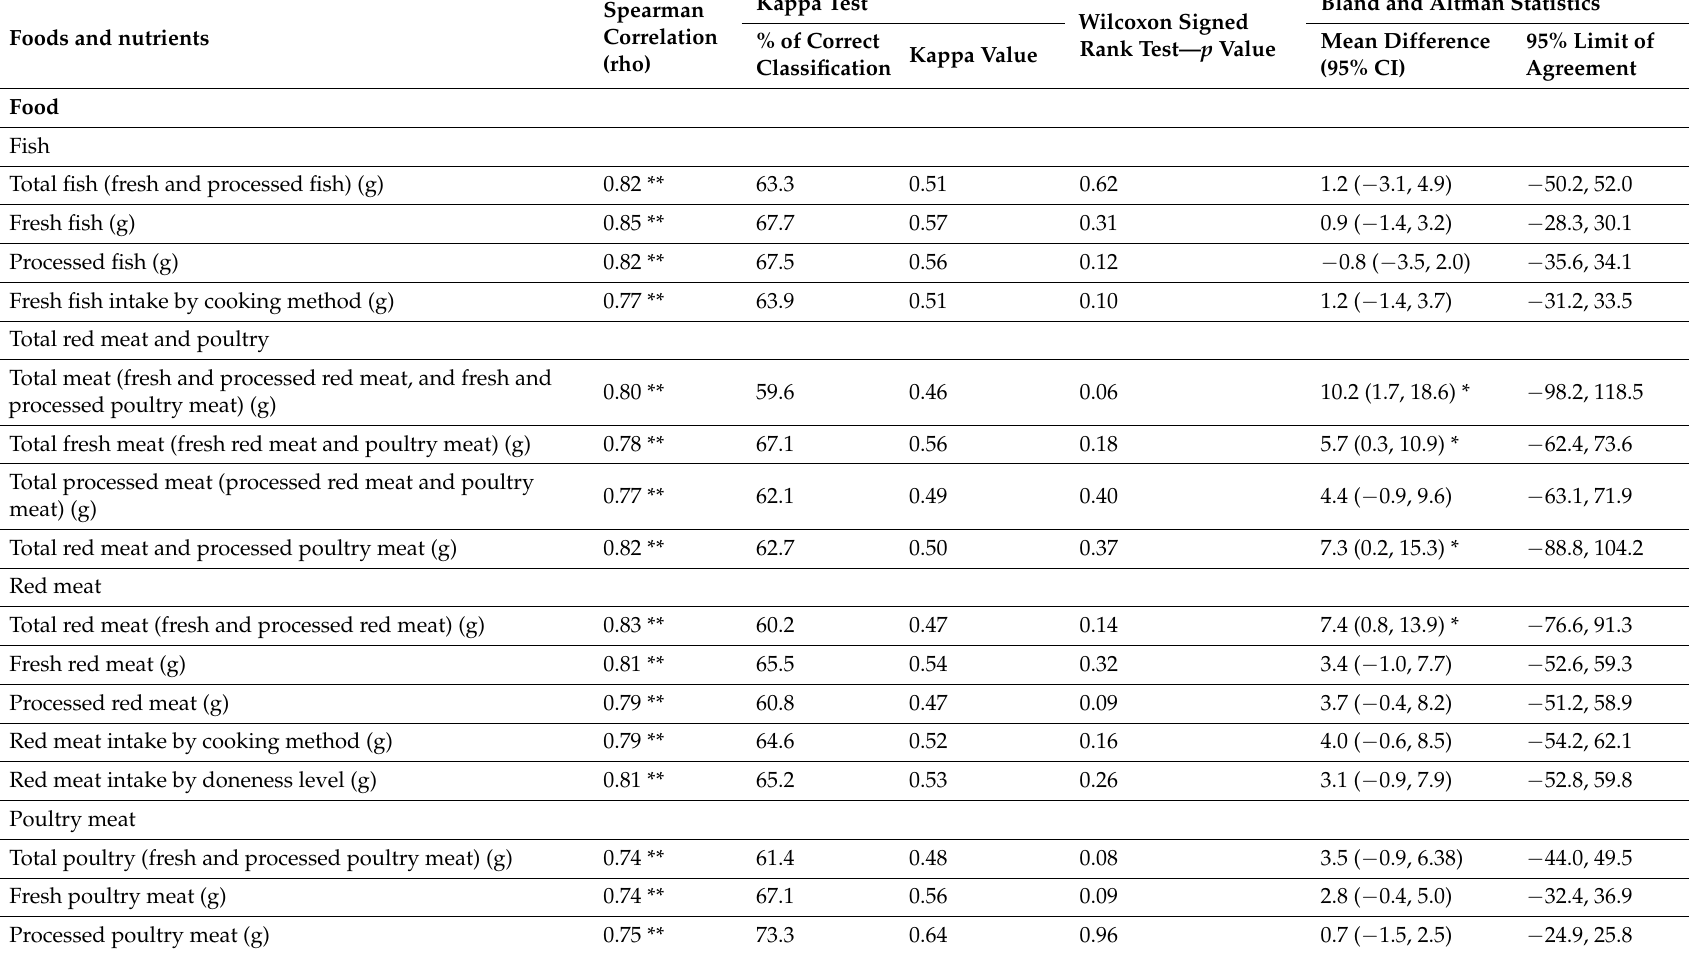
Table 3. Reproducibility of food and nutrient intake between FFQ1 and FFQ2, n =